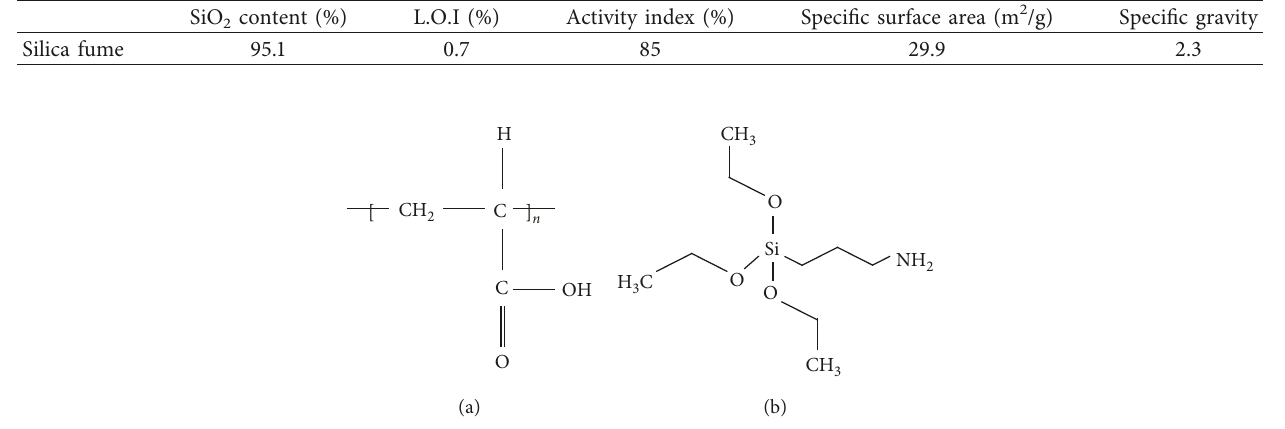
Figure 1: Abbreviated molecular structure of PAA (a) and KH-550 Table 2: Physical index of PAA and KH-550.